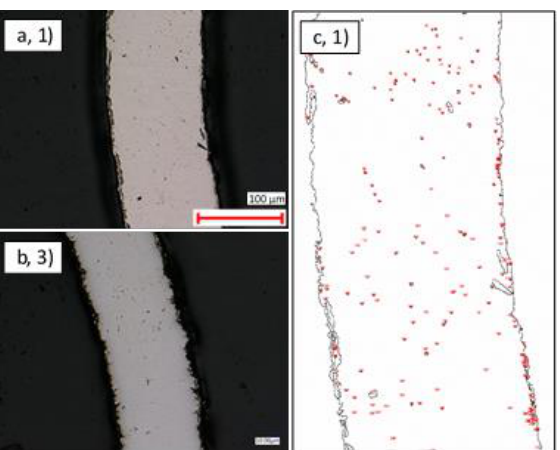
Figure 9. ×1000 magnification view of the cross-sectional surface of samples: ( a ) CuNi thin-walled pipe (1); ( b ) Ti thin-walled pipe (3); ( c ) CuNi thin-walled pipe after ImageJ threshold was applied (1).